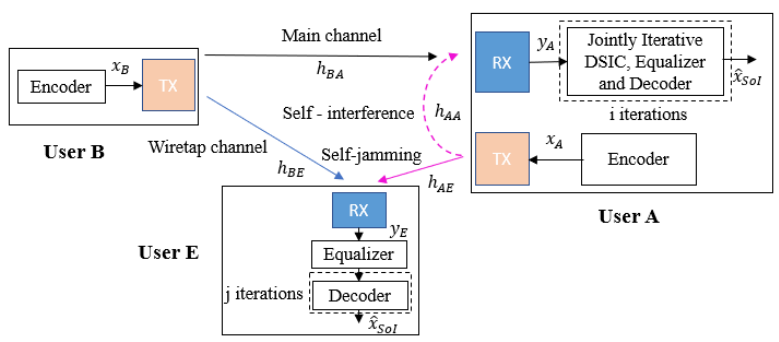
Figure 5. Blind feedback scheme at user A in case of a passive